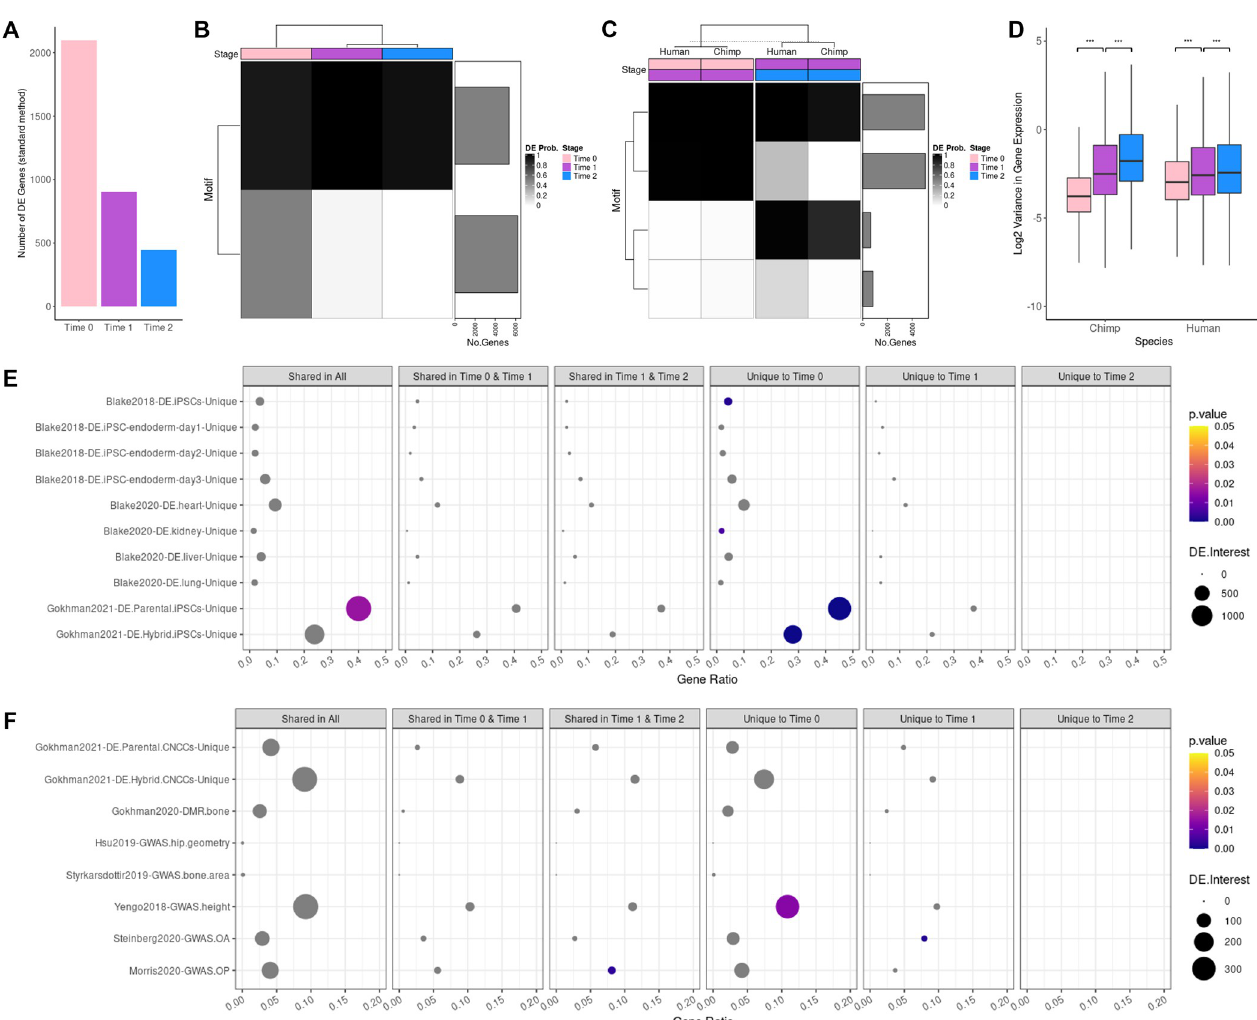
Fig 3. Interspecific DE across three stages of osteogenic differentiation. Bar plot showing the number of interspecific DE genes identified for each stage of differentiation using standard methods (A). Correlation motifs based on the probability of differential expression between species for each stage of differentiation (B) and correlation motifs based on the probability of differential expression across stages of differentiations for each species (C) with the number of genes assigned to each motif shown in the bar plot on the right and the posterior probability that a gene is DE shown by the shading of each box. Box plots of the log2 transformed gene expression variance values for cells collected at each stage of differentiation for each species ( ��� p < 0.001) (D). Enrichment of external DE gene sets among Cormotif interspecific DE genes identified for each stage of differentiation for validation (E) and functional interpretation (F) with the p-value (p.value), the number of DE genes overlapping an external gene set (DE.Interest), and the ratio of overlapping to non- overlapping DE genes for a given external gene set (GeneRatio)